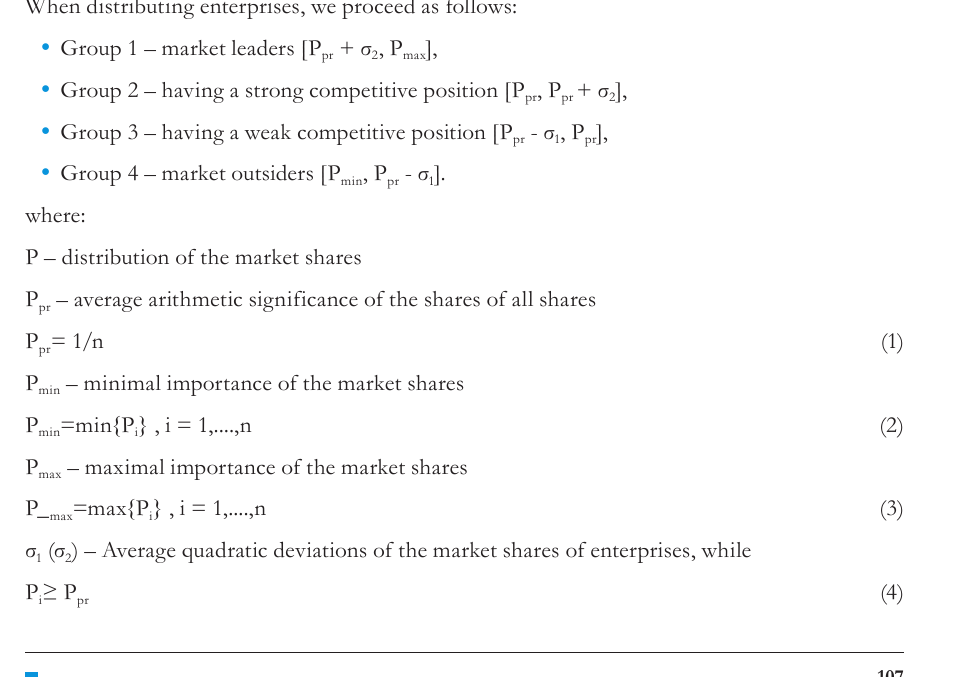
Fig. 1 – Distribution of the market shares of competitors in terms of their production. Source: own research σ shows the interval of weak and σ the interval of strong competitive positions. The enterprise 1 2 group IV shows outsiders and I. indicates